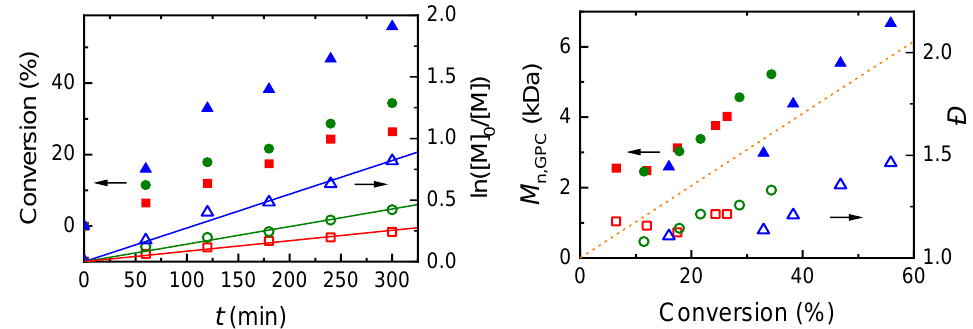
reduction of Fe(III). 4 Monomer conversion. 5 Apparent polymerization rate constant determined as the slope of ln([M] 0 /[M]) vs. t . 6 Determined by GPC. 7 Theoretical molecular weight. 8 In the pres- ence of a 2-fold excess of TPP with respect to FeCl 3 . 9 In the presence of a 2-fold excess of TPMA with respect to FeCl 3 .